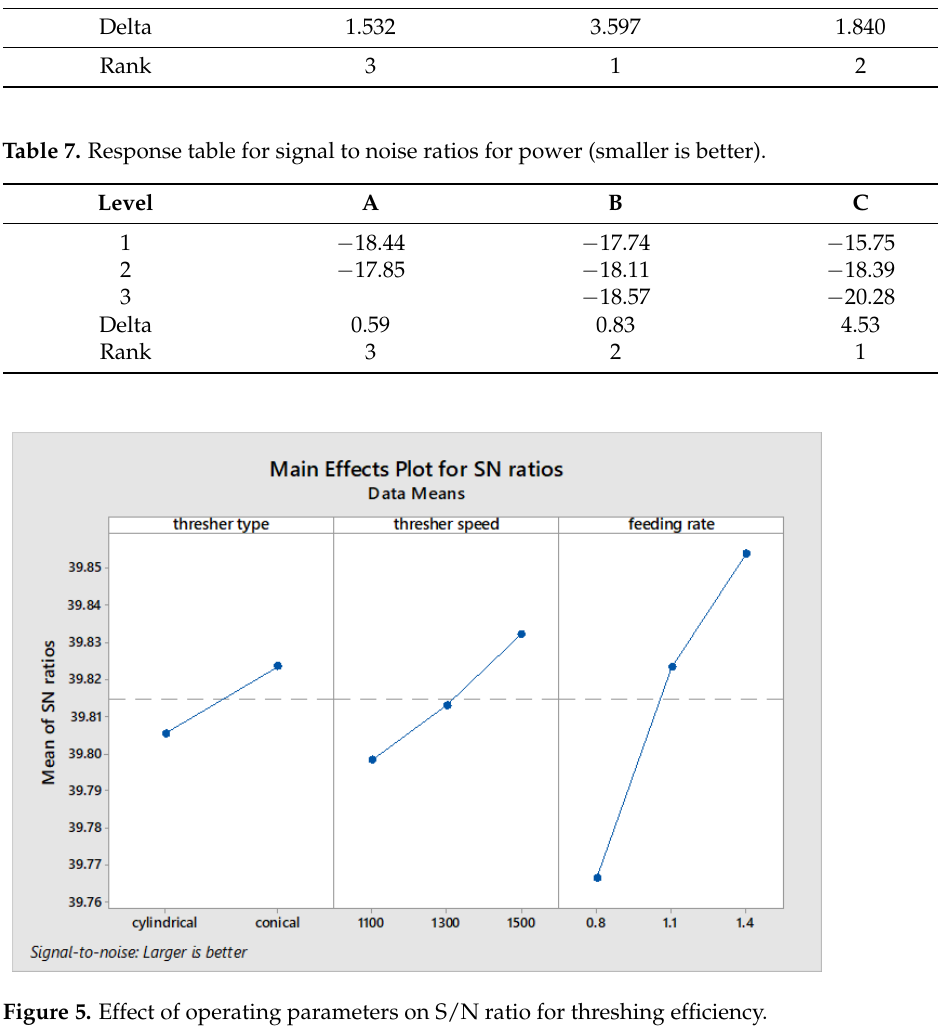
Figure 5. Effect of operating parameters on S/N ratio for threshing efficiency. Table 6. Response table for signal to noise ratios for productivity (larger is better).